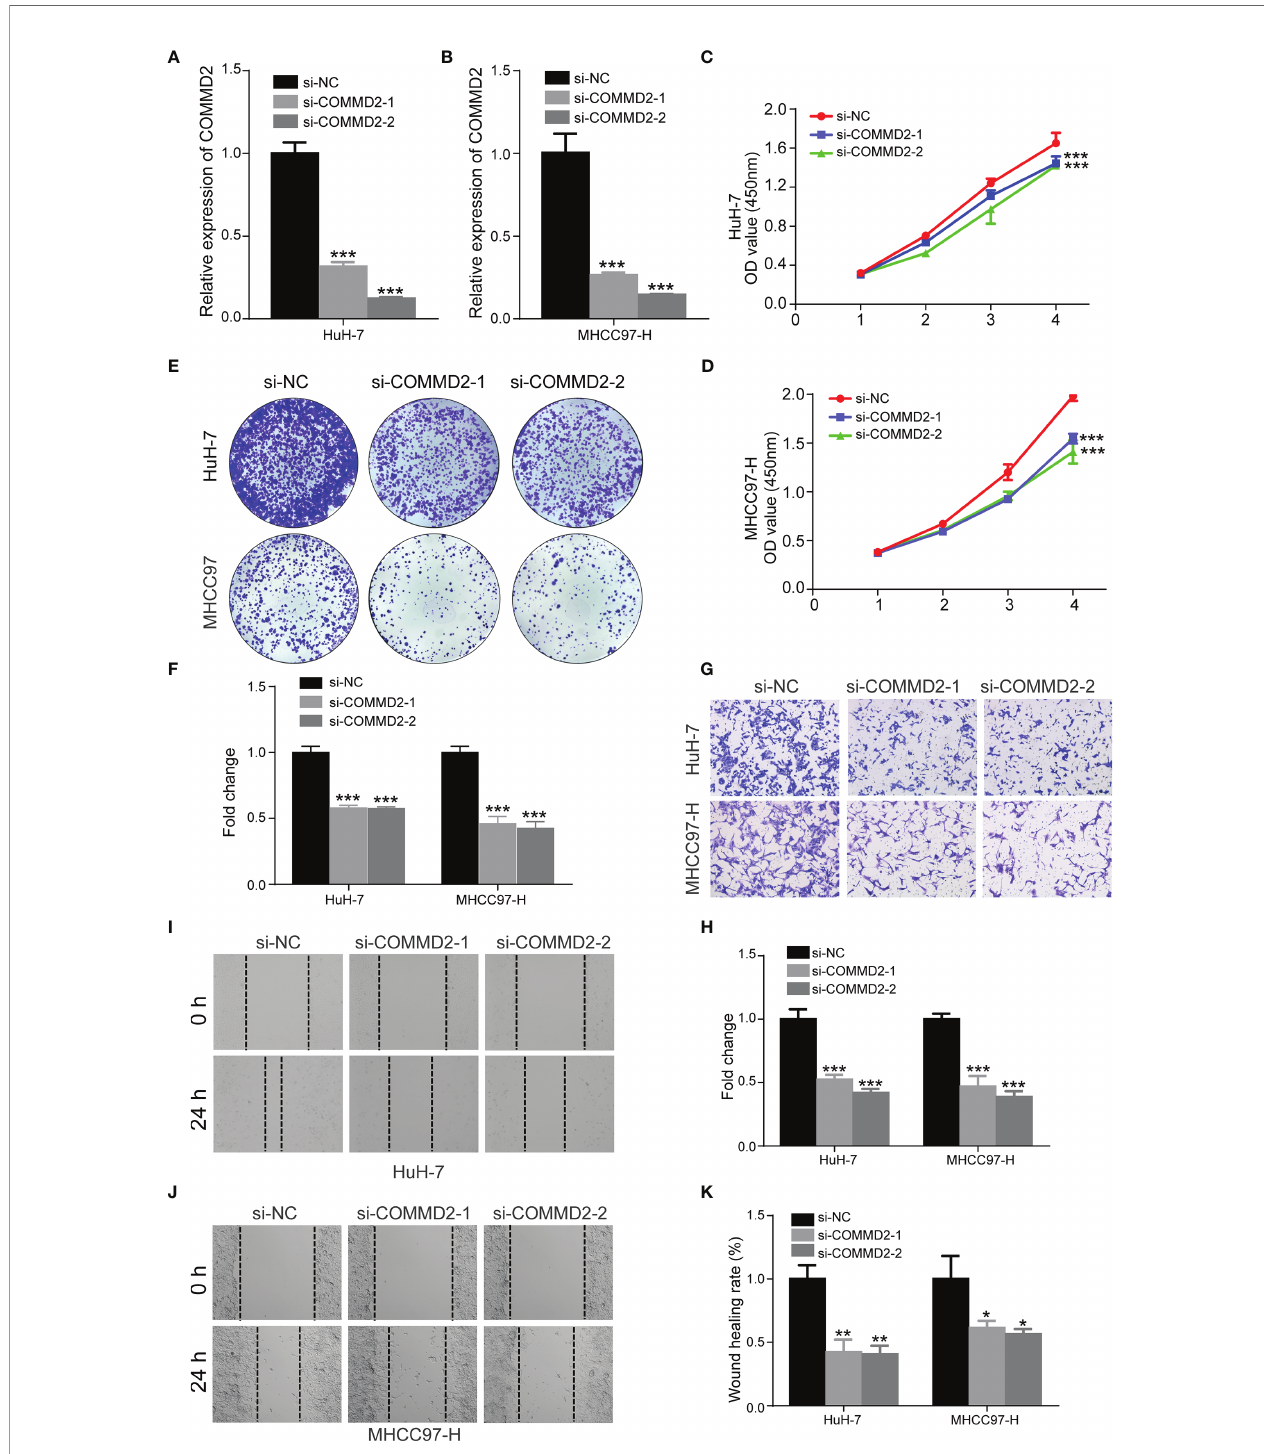
FIGURE 11 | Effects of COMMD2 knockdown on the proliferation and migration of LIHC cells. (A, B) The ef fi ciency of COMMD2 downregulation in HuH-7 (A) and MHCC97-H (B) cells after COMMD2 siRNA transfection was detected by RT-qRCR. (C – F) Effect of COMMD2 knockdown on the proliferation of HuH-7 and MHCC97-H cells as determined by CCK8 (C, D) and colony formation assays (E, F) . (G – K) Effect of COMMD2 knockdown on the migration of HuH-7 and MHCC97-H cells as detected by transwell (G, H) and wound healing assays (I – K) . Scale bar=50 m m. *P < 0.05; **P < 0.01; ***P <